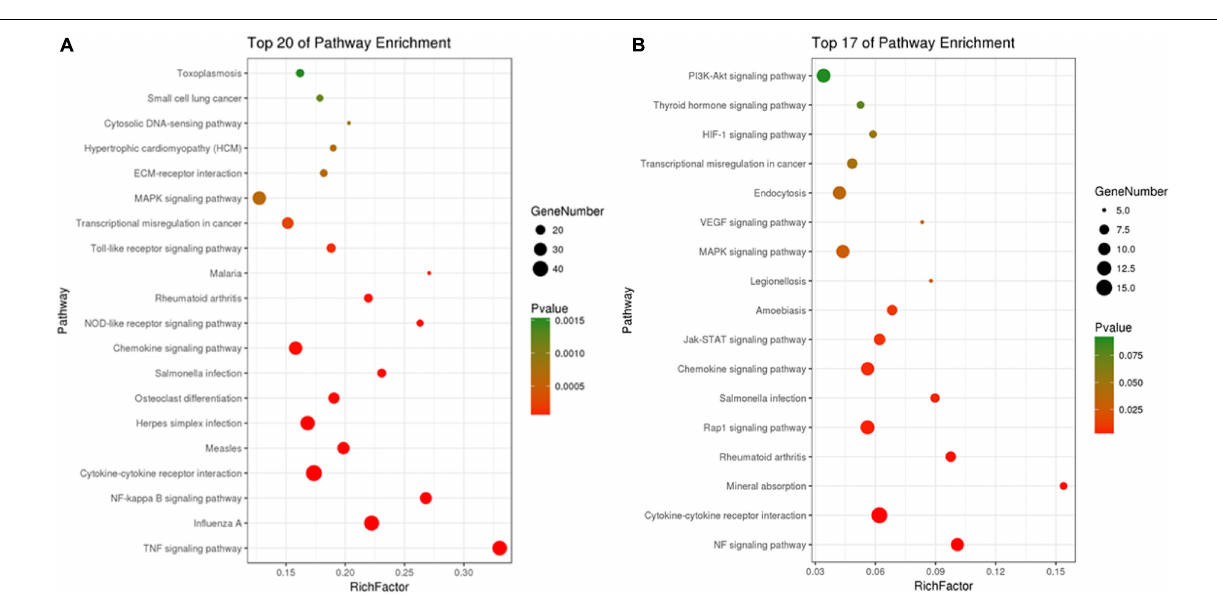
FIGURE 6 | Scatter plot of KEGG pathways enrichment of DEGs in C vs. LPS (A) and LPS vs. HOA (B)